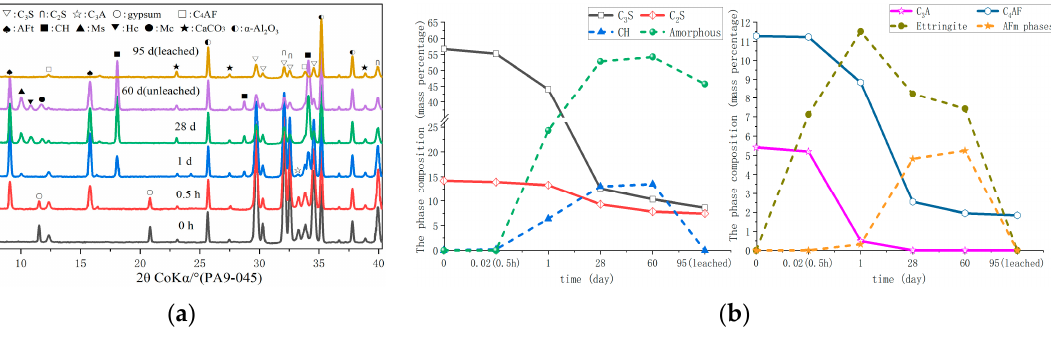
Figure 8. The phase composition of hydrated and leached PA9-045 cement pastes: ( a ) XRD; ( b ) the content of phase composition.